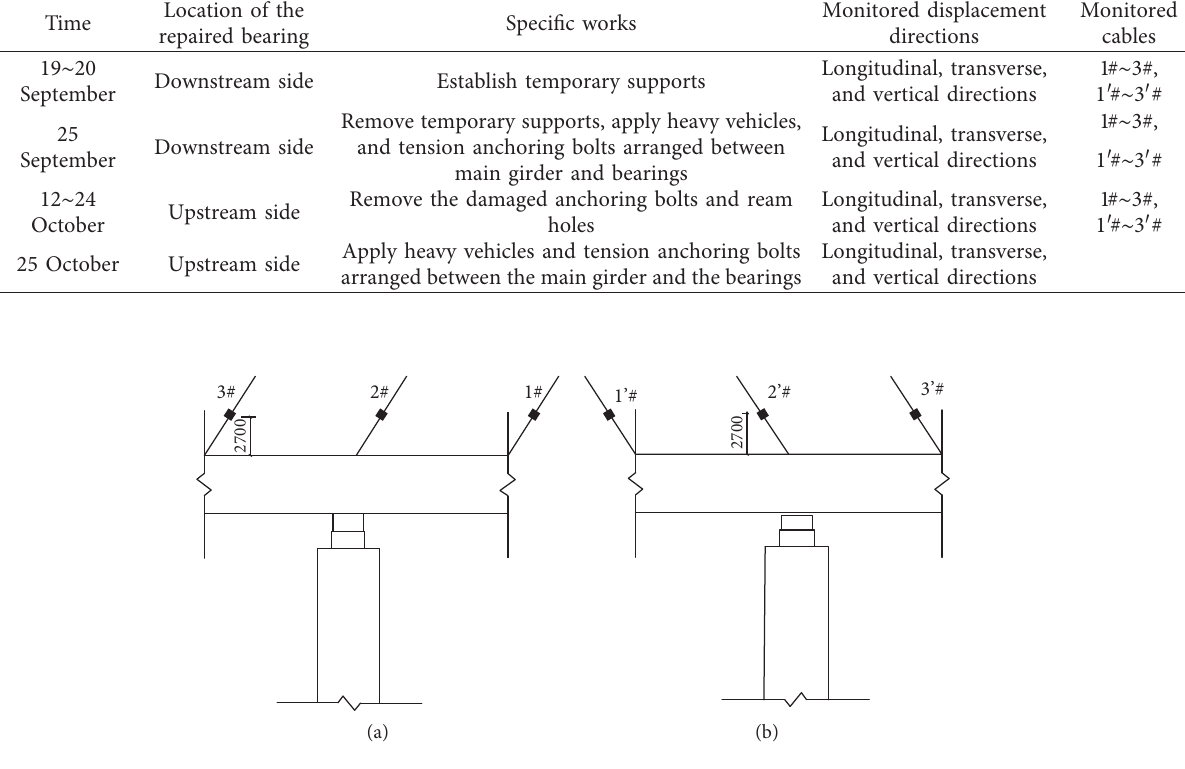
Figure 24: Monitored stayed cables above auxiliary piers with accelerometers arranged (unit: mm): (a) upstream side and (b) downstream side.